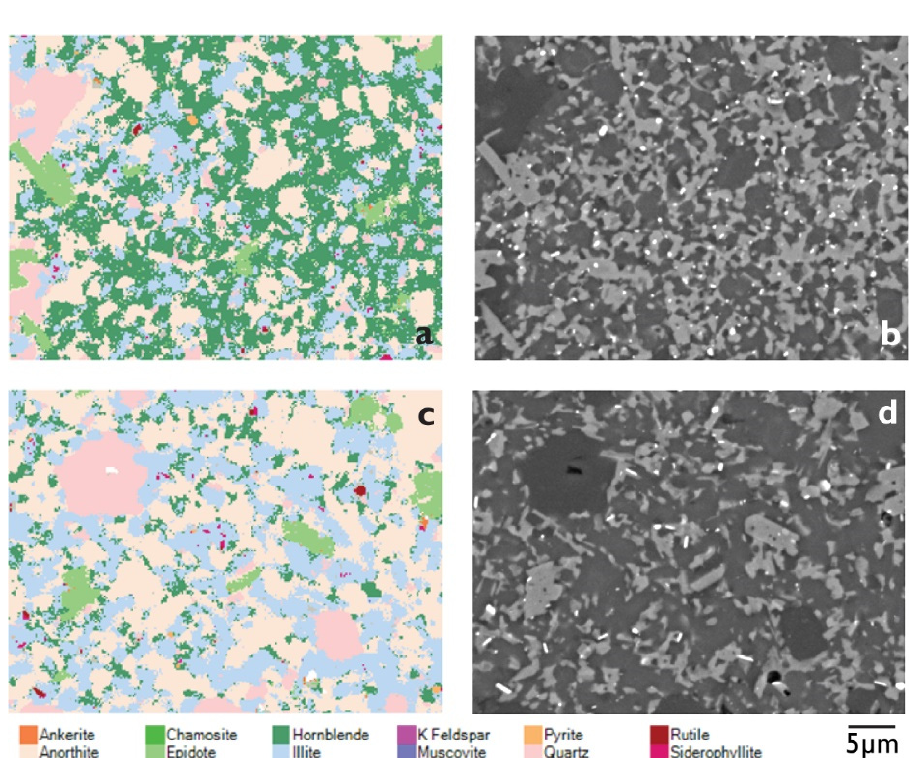
Figure 5. Two details of Figure 2: Combined false ‐ colored mineral map ( a and c ) and BSE images ( b and d ) for textural group 1 ( a and b ) and textural group 2 ( c and d ). The width of view for each field is 46 microns.